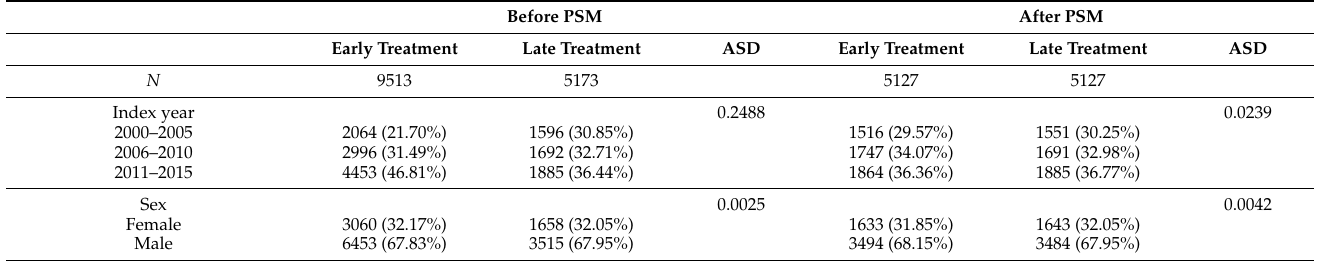
Table 1. Baseline characteristics among study